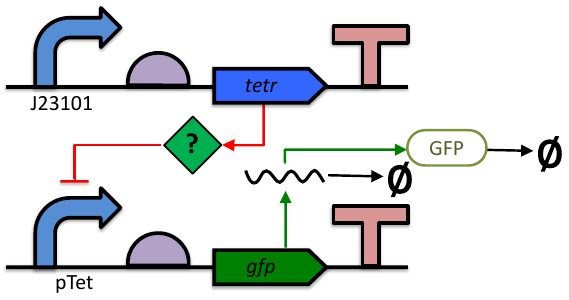
Figure 40: Constitutive production of TetR, except that information about the protein is missing, leaving it as the default unspecified glyph. TetR represses the pTet promoter, which is regulating production of GFP. The diagram of GFP production explicitly includes the intermediate mRNA and the degradation of both the mRNA and protein products.